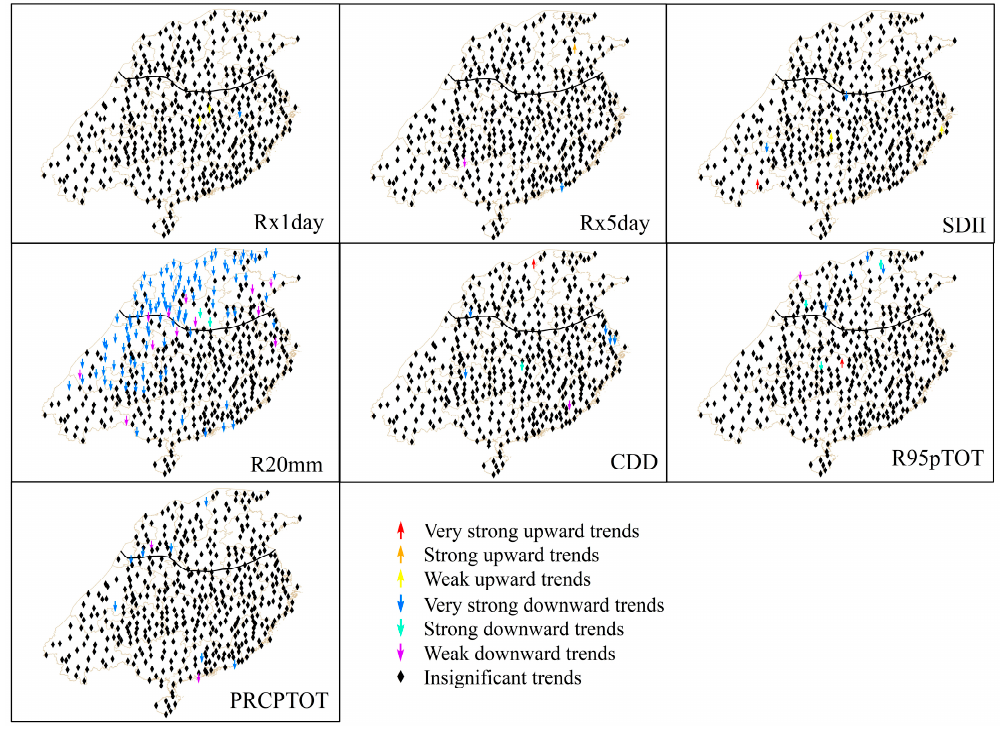
Figure 5. Spatial distributions of the trend strengths for the extreme precipitation indices in the study area during the growth period of October 1961 to May